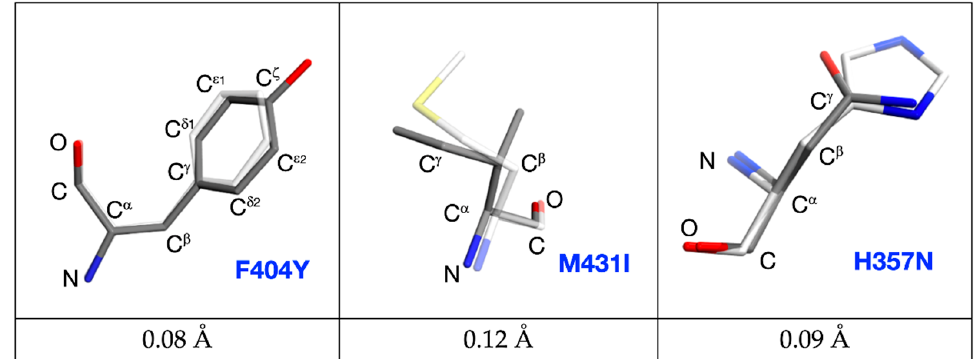
Figure 6. Comparison of the F404-Y404; M431-I431 and H357-N357 positions in wild-type and mutated variants. Wild type PB2 residues are sketched in white-stick representation; mutated forms are in dark-stick representation with common atoms labelled. Root-mean-square deviations calculated for common atoms are listed below.